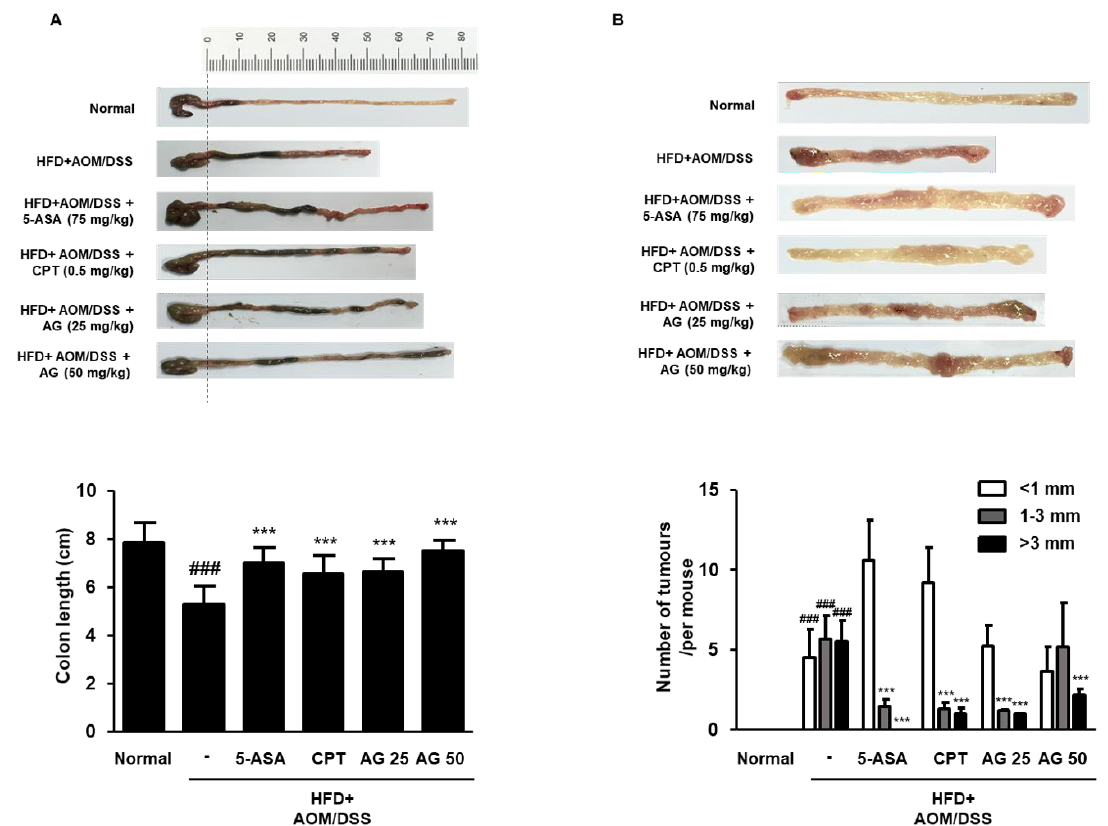
Figure 4. Effects of AG on the colonic tissues in the HFD-propelled CAC mice model. ( A , B ) The colons were obtained after 63 days of AOM treatment and the representative photographs of colon tissues from each group are provided. The length of the colon of each animal was measured between the caecum and proximal rectum. ( A ) The colon length and ( B ) the number of macroscopic tumors were measured. The values are the mean ± SD ( n = 10); ### p < 0.001 vs. normal group; *** p < 0.001 vs. the HFD+AOM/DSS group; significant differences between the treated groups were determined by ANOVA and Dunnett’s post-hoc test.